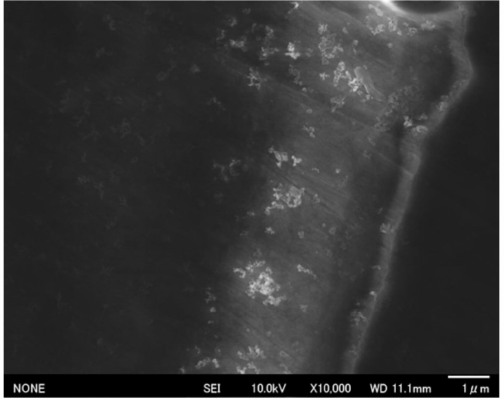
Figure 6. SEI of a HAP part of Mg–10HAP after sintering using SPS system.